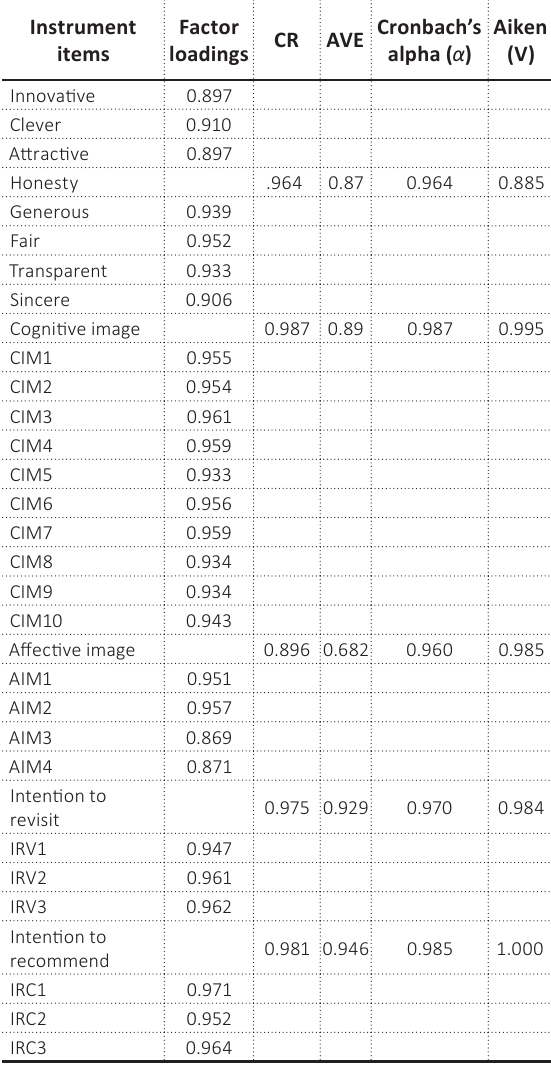
Table 2. Instrument